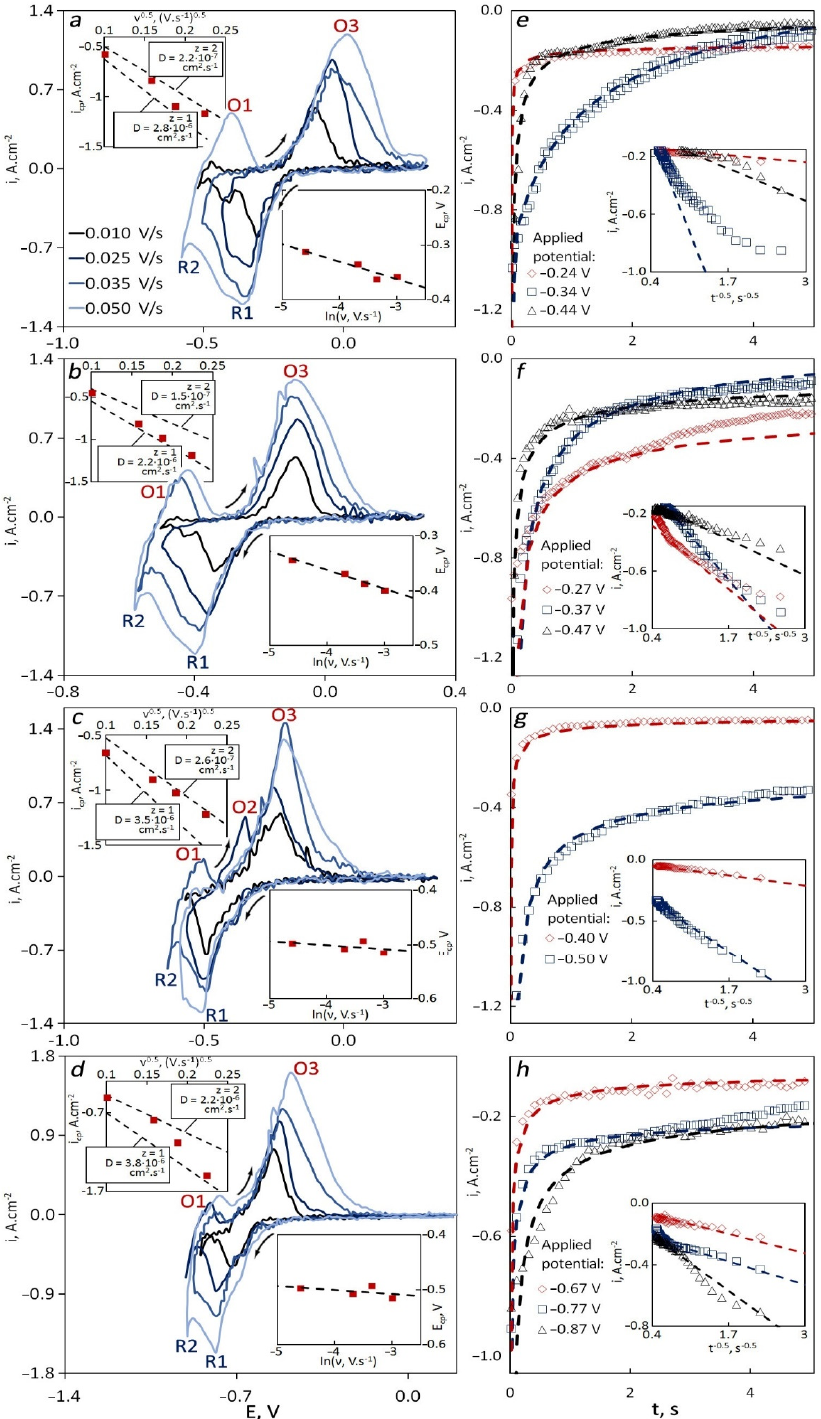
Figure 5. CVs ( a – d ) and chronoamperograms ( e – h ) recorded for tungsten in 64LiF–36AlF 3 (with 5 wt.% of spent catalyst) with the dependencies of cathodic peak current density vs. square root of sweep rate, cathodic peak potential vs. logarithm of sweep rate and current density vs. time to the power − 0.5 for different temperatures: ( a , e ) 740 ◦ C, ( b , f ) 760 ◦ C, ( c , g ) 780 ◦ C, ( d , h ) 800 ◦